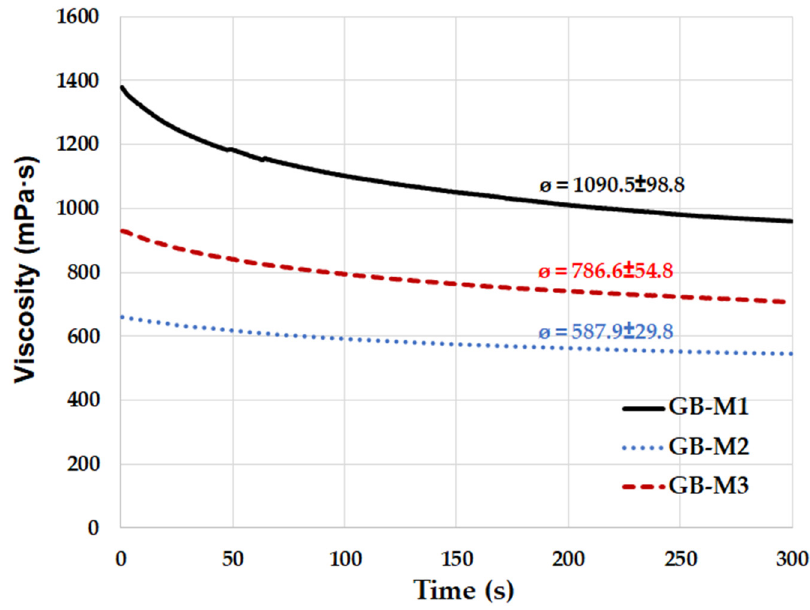
Figure 3. Viscosity measurement of geopolymer binders with different type of aluminosilicate.